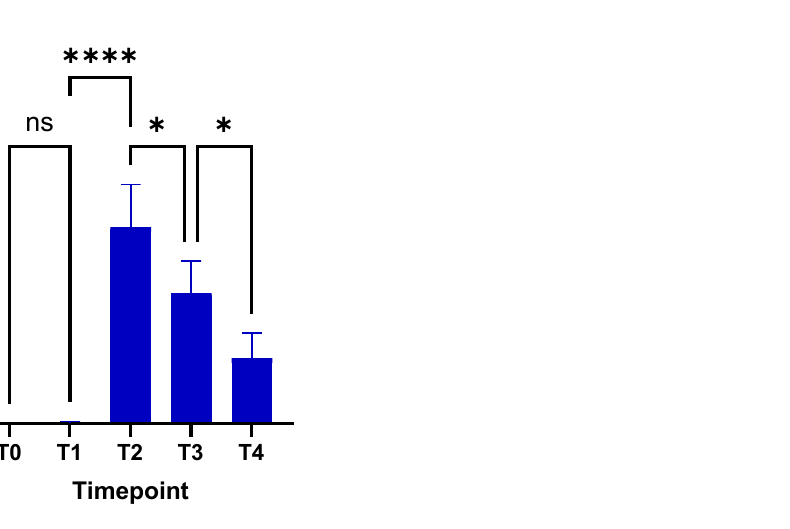
Figure A1. Univariate analysis of seroconversion at different time points for lung cancer patients; mean antibody titers with 95% confidence intervals (y axis) relative to timepoint assessed (x axis); ns: no statistical significance ( p = 0.99); ****: statistically significant difference ( p < 0.0001); *: no statistically significant difference between T2 versus T3 ( p = 0.02) and T3 versus T4 ( p = 0.03).